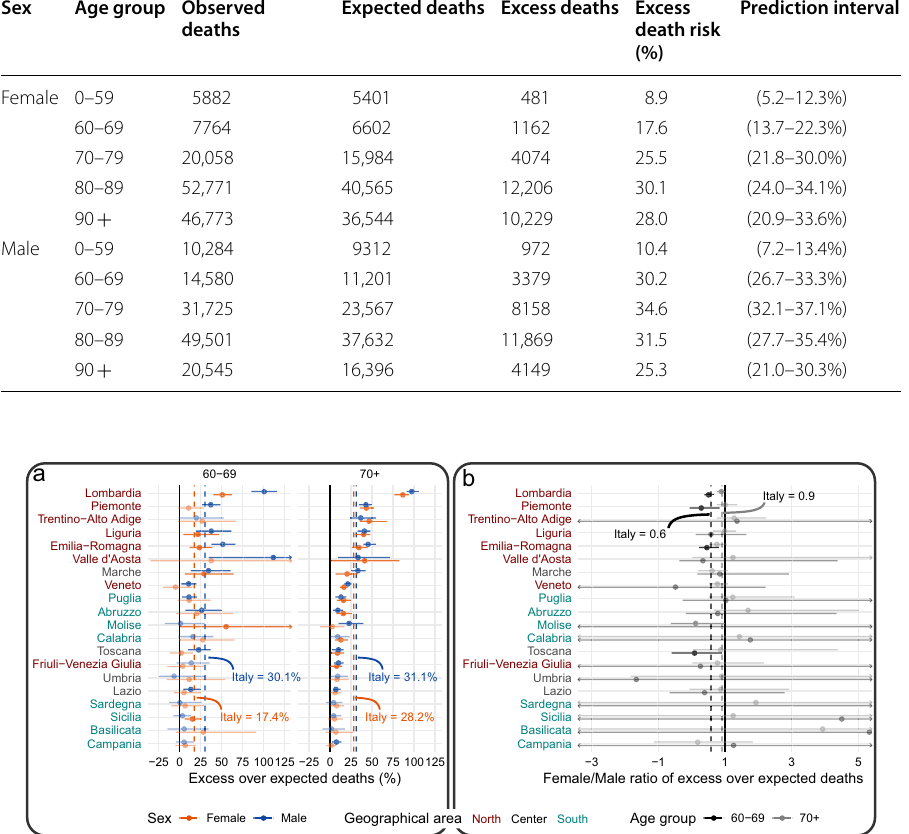
Fig. 1 Excess death risk by sex and 20 Italian regions for the age groups 60–69 and 70 between women’s and men’s excess death risk ( b ). Regions are ordered according to the total value of excess over expected deaths observed for the age group 70